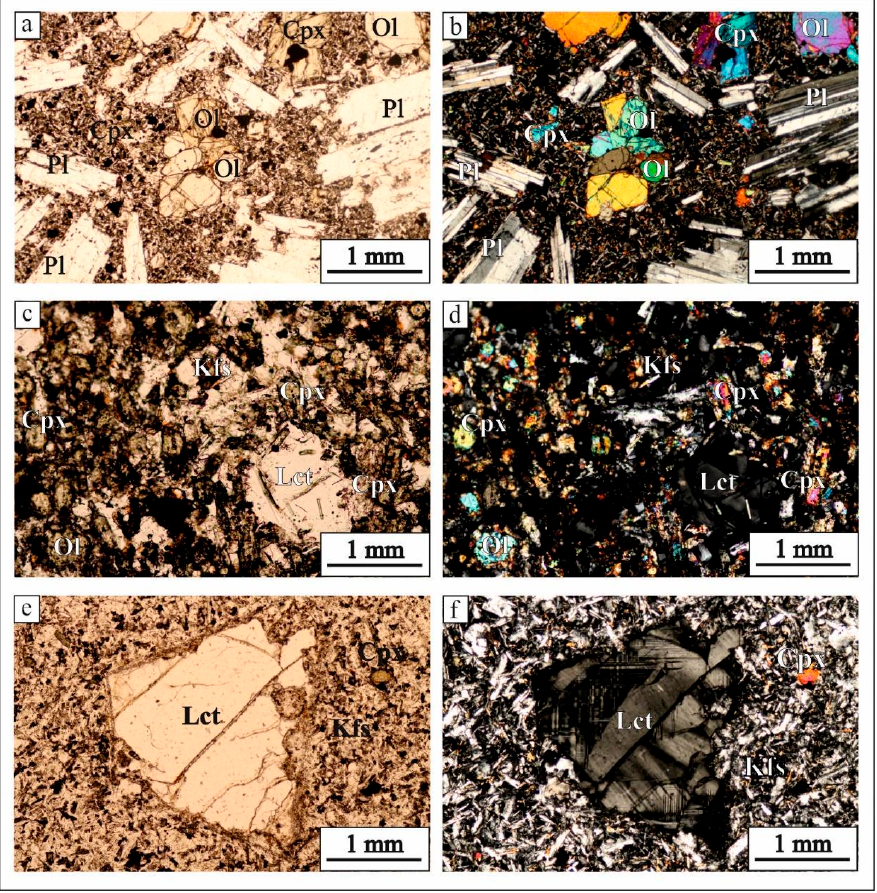
Figure 2. PL and XL picture of thin sections. ( a , b ) sample L14A: olivine alkali basalt, trachytoid texture with phenocrysts of plagioclase, olivine and pyroxene in a groundmass of K-feldspar, cpx and nepheline; ( c , d ) sample L14B: Leucititic phono tephrite: leucite phenocrysts in an interstitial intergranular groundmass of cpx, plagioclase, K-feldspar and nepheline; ( e , f ) Sample L15: leucitophyre showing large leucite phenocrysts immersed in a trachytic groundmass of K-feldspars, cpx. The L14B sample was a seriate porphyritic rock with phenocrysts of euhedral zoned cpx (augite-diopside), leucite and olivine (chrysotile-hyalosiderite) in a groundmass